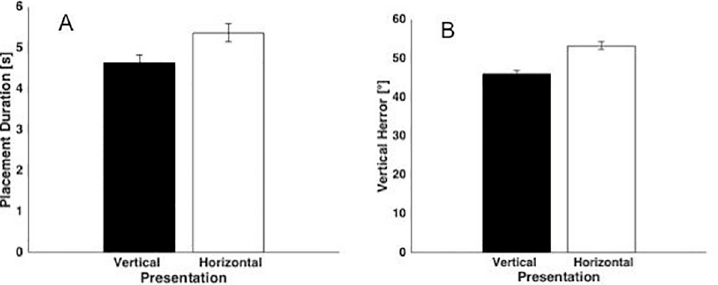
Fig 5. Significant orientation effects: Means ± SE are reported: A) effect of orientation on placement duration; B) effect of orientation on Horizontal